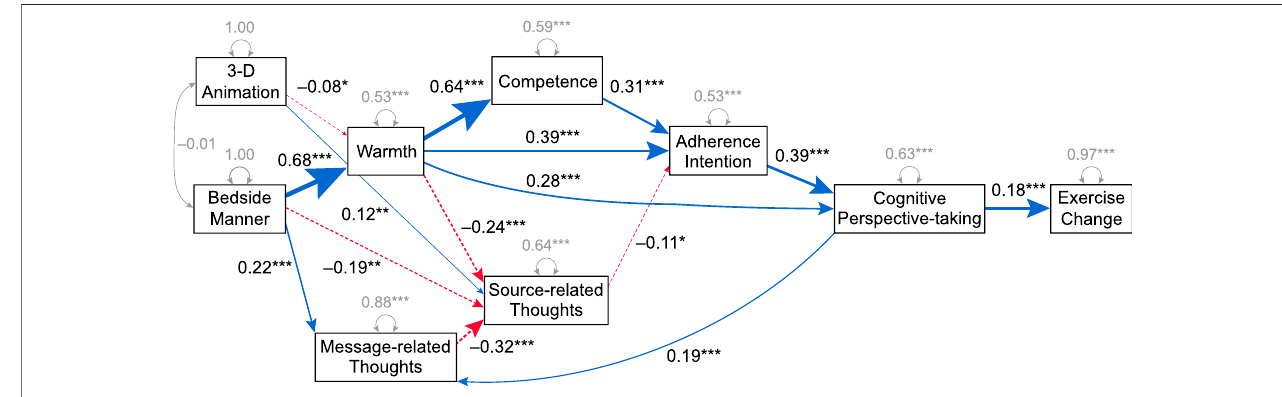
FIGURE 8 | Model 7: Path model of Exercise Change with both SCM and HSM variables. The number of source-related thoughts and message-related thoughts were incorporated into Model 4.